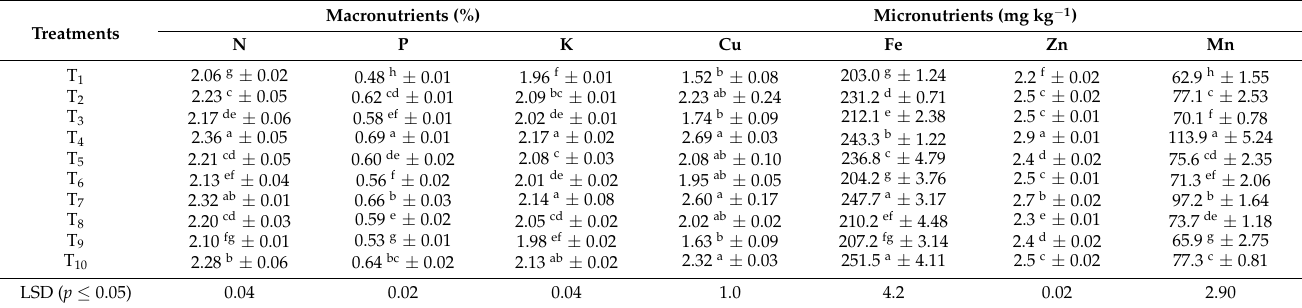
Table 3. Effects of panchagavya, jeevamrut, and organic manures on the macronutrient and micronu- trient contents of